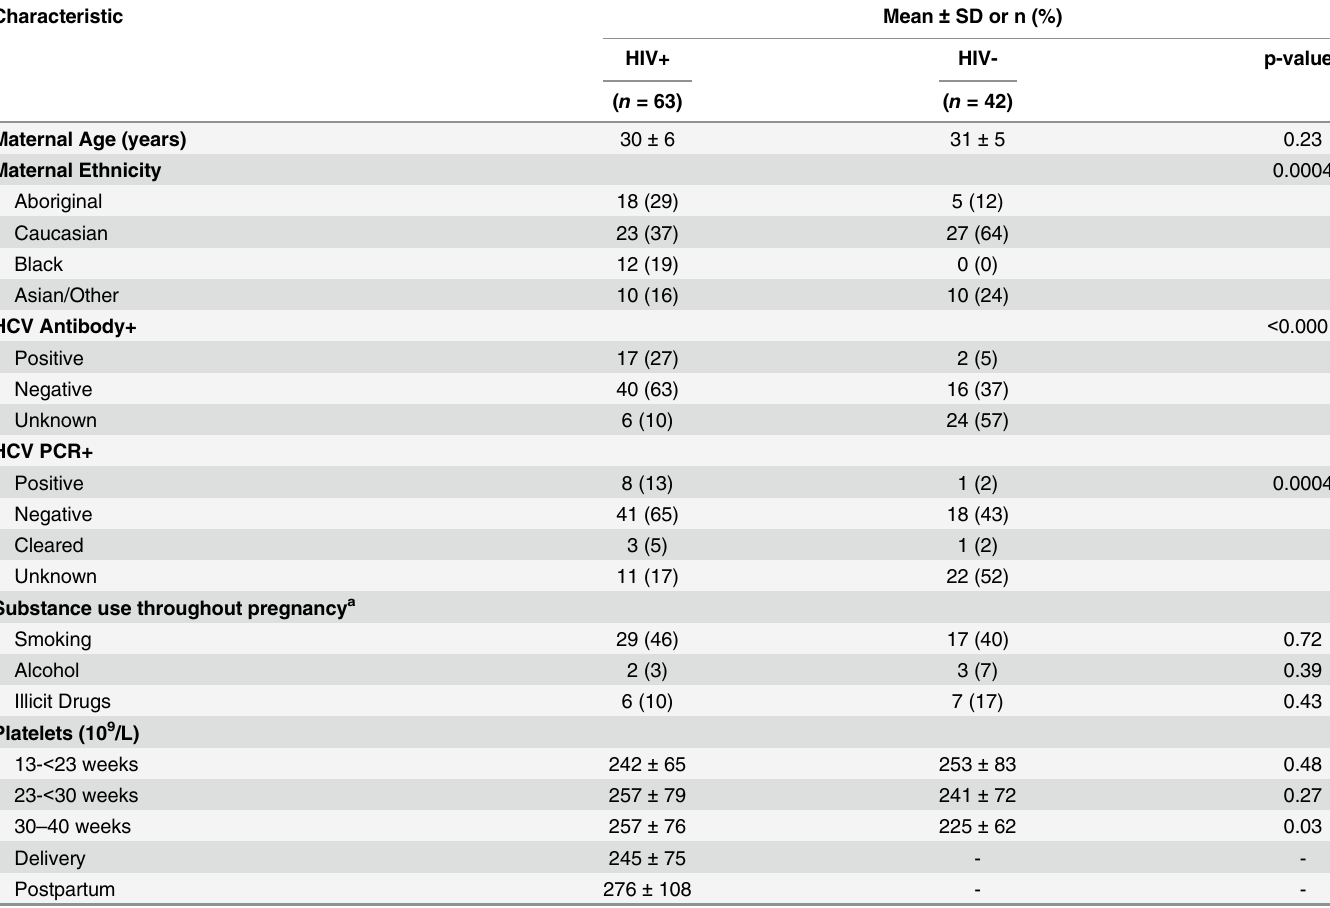
Table 1. Demographic, clinical and laboratory characteristics of study participants (n =